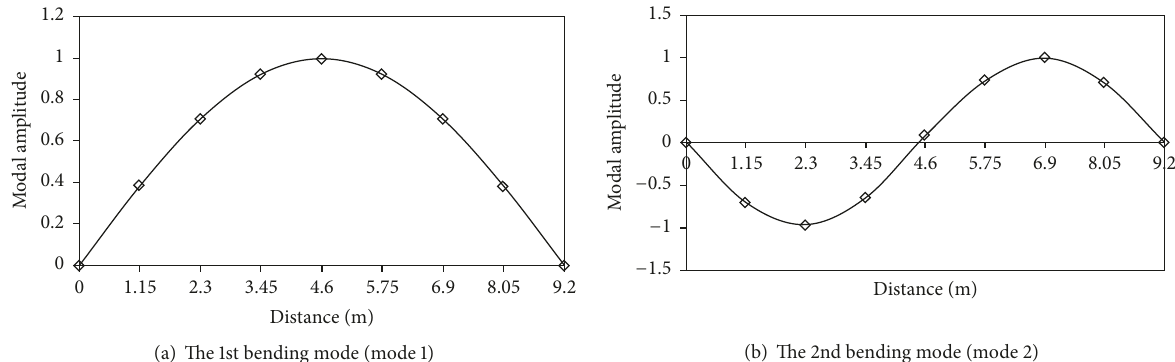
Figure 18: ((a)-(b)) Two analytical mode